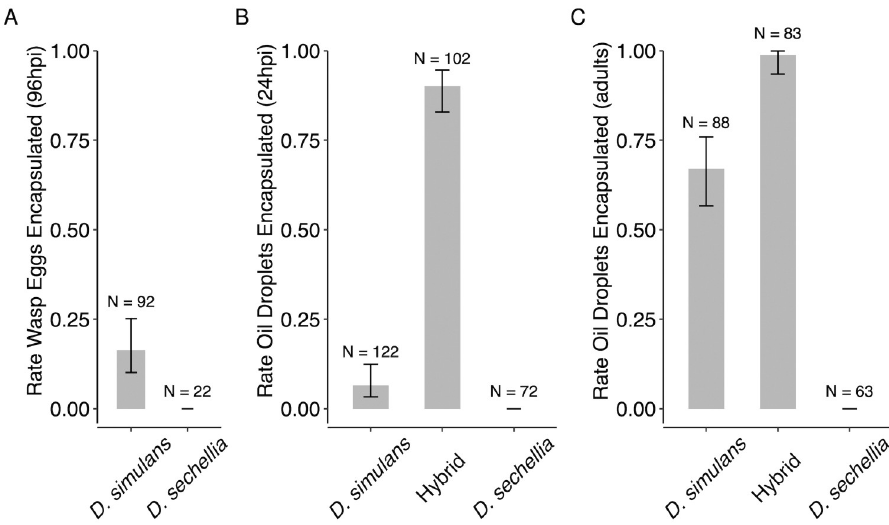
Fig 1. The immune response of two species of Drosophila and their hybrids. (A) The proportion of larvae that had encapsulated eggs of the parasitoid wasp L. boulardi 96 hours post infection (96hpi). (B and C). The proportion of encapsulated droplets of mineral oil containing wasp homogenate in (B) larvae 24 hours post injection or (C) in adult flies that developed from injected larva. Error bars are 95% binomial confidence